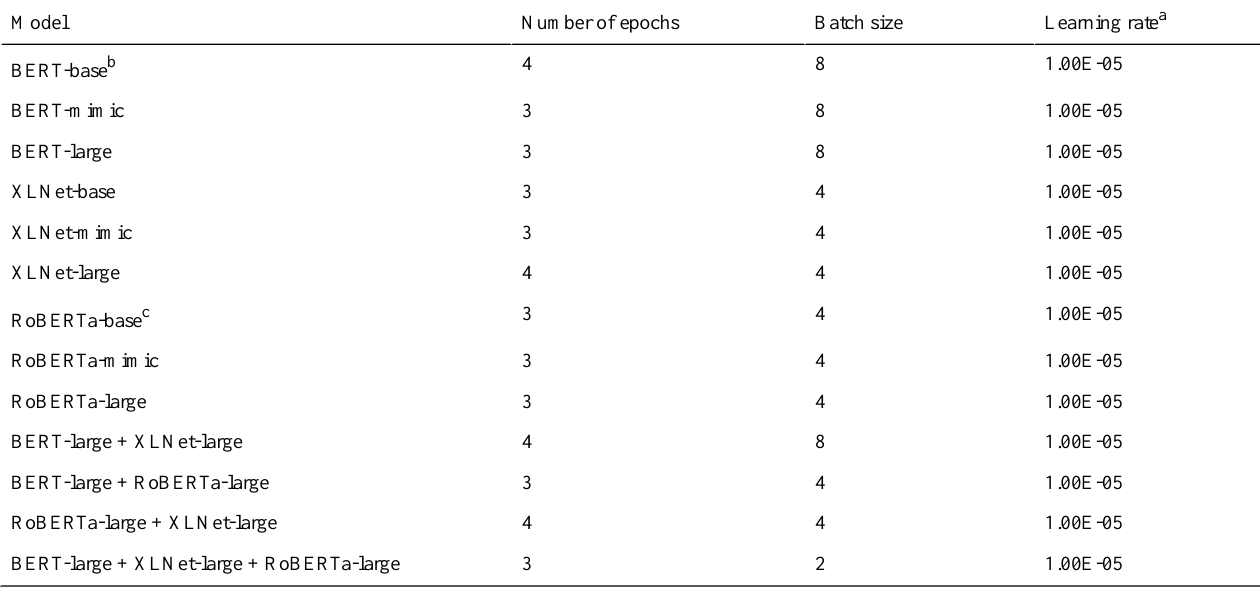
Table 2. Hyperparameters for transformer